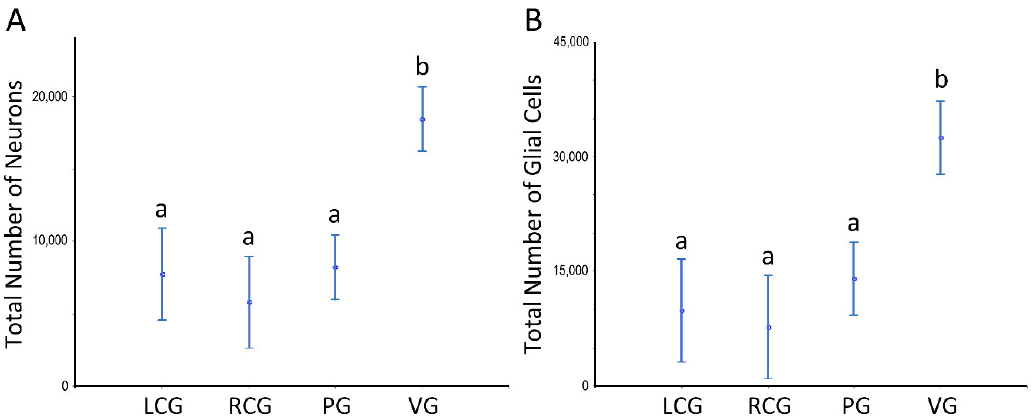
Figure 8. Number of neurons and glial cells in the ganglia of S. plana ; data from all sex conditions combined. ( A ) Neurons. ( B ) Glial cells. Different letters mean significant differences. Data as mean and 95% confidence interval. LCG: left cerebral ganglion; RCG: right cerebral ganglion; PG: pedal ganglion; VG: visceral ganglion. Six animals per sex condition were used.